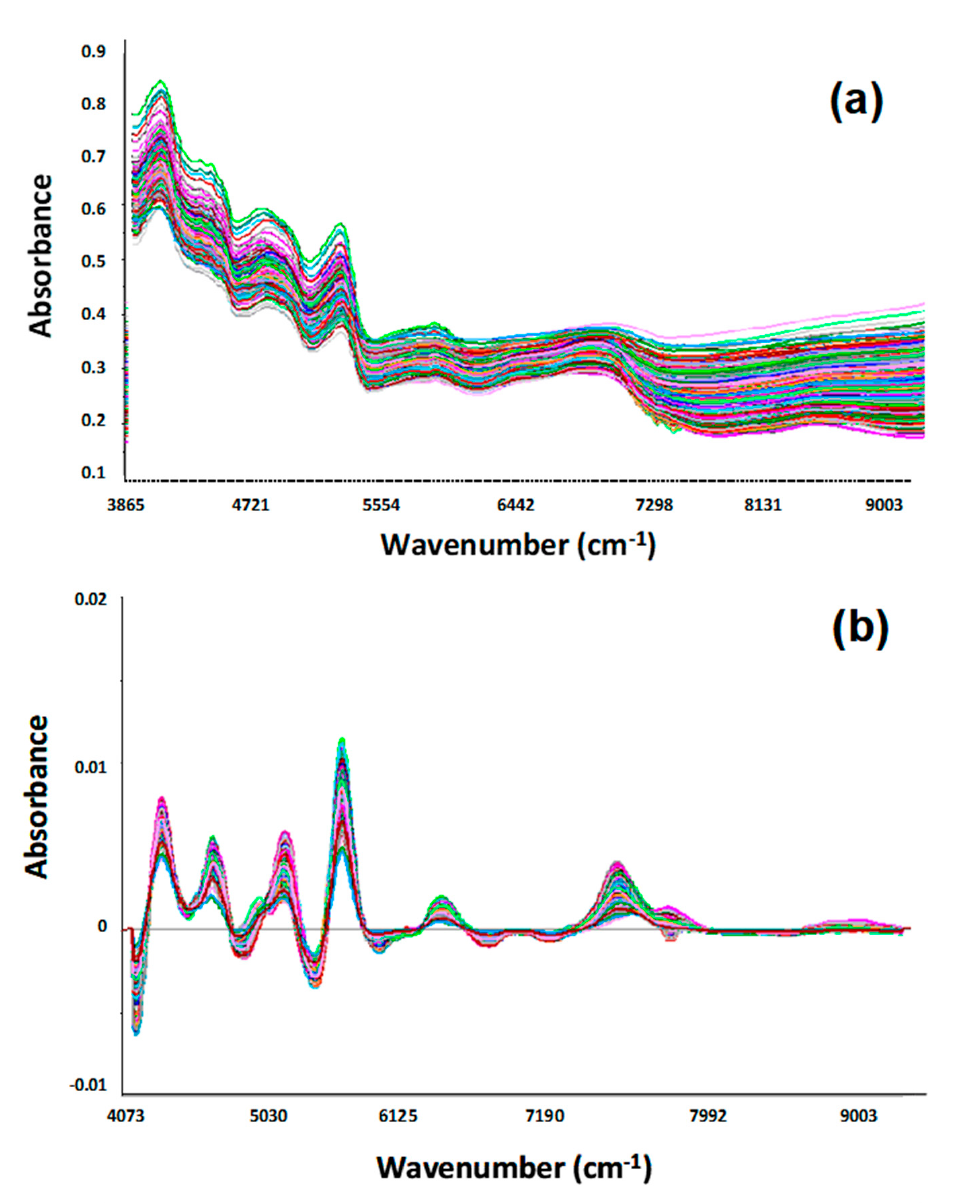
Figure 7. Optimized near-infrared (NIR) spectra in dry pasture samples; ( a ) for crude protein (CP) using raw data spectral processing; and ( b ) for near detergent fiber (NDF) using 1st derivative spectral preprocessing.